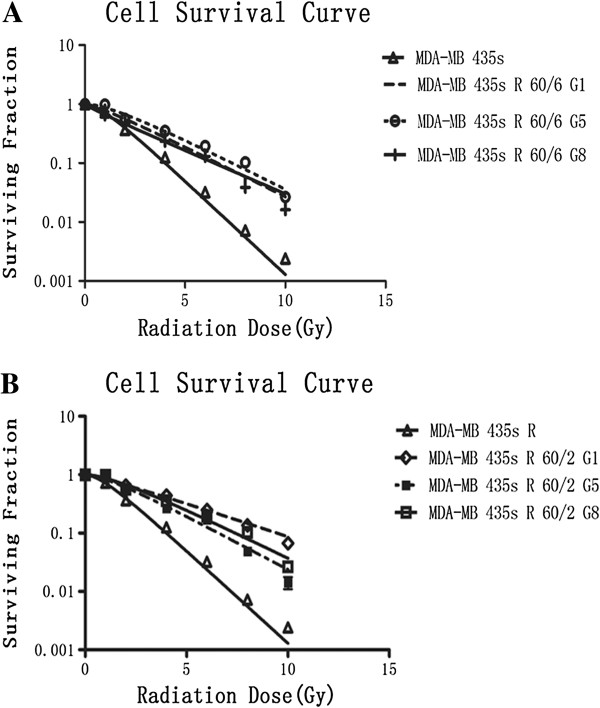
Clonogenic assay. A and B described the cell survival condition after irradiation. X-ray irradiation was performed as planed in 6 Gy/fraction and 2 Gy/fraction with total dose 60 Gy. An appropriate number of cells in different generations were seed in 6-well plates. Each group was irradiated at the dose of 0 Gy, 1 Gy, 2 Gy, 4 Gy, 6 Gy, 8 Gy, 10 Gy, respectively. After incubation for 14 days, the colonies were fixed and stained by crystal violet. The coloniesâ€‰>â€‰50 cells were scored as viable colonies. The data was analyzed by single-hit multi-target model and survival curve of each group was described by Graphpad prism 5.0 software.